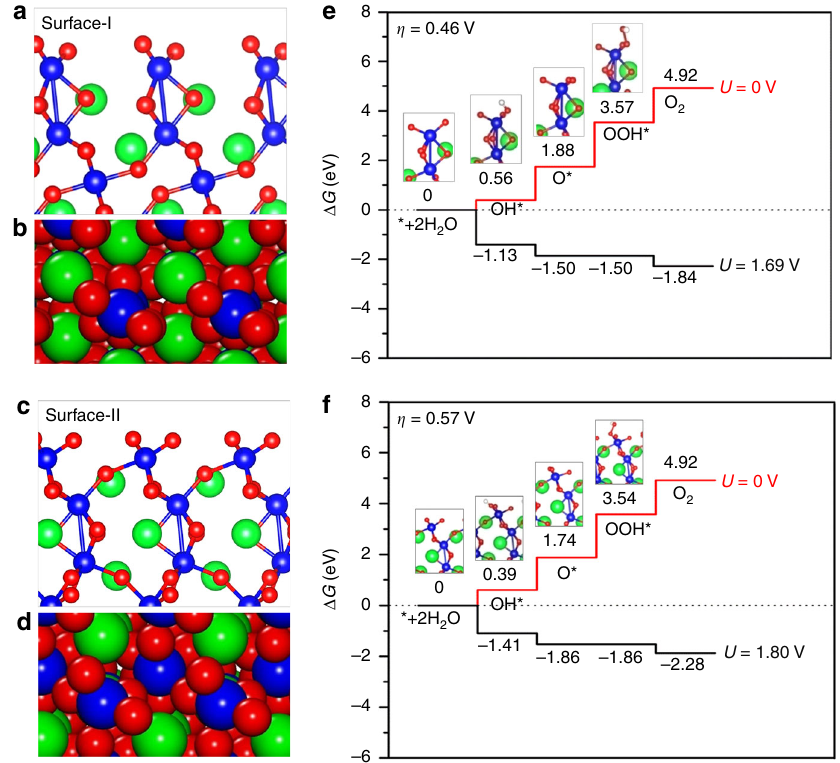
Fig. 4 Theoretical understanding of electrocatalytic activity for OER of 6H-SrIrO 3 . a Side and b top views of the surface-I of 6H-SrIrO 3 ; c Side and d top views of the surface-II of 6H-SrIrO 3 ; free-energy diagrams of four elementary reaction steps for the OER on e the surface-I and f surface-II of 6H-SrIrO 3 at the different applied potentials. The optimized structures of HO, O, and HOO adsorptions on the surface-I and surface-II are also shown in e and